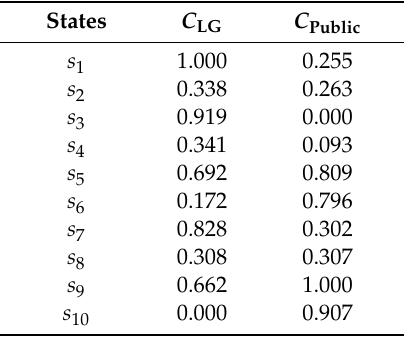
Table 6. Values of C LG and C Public